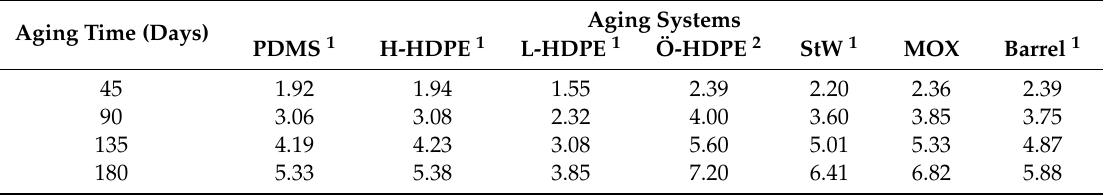
Table 1. Dosages of oxygen (mg / L) carried out during the aging period in the di ff erent aging systems. Aging Time